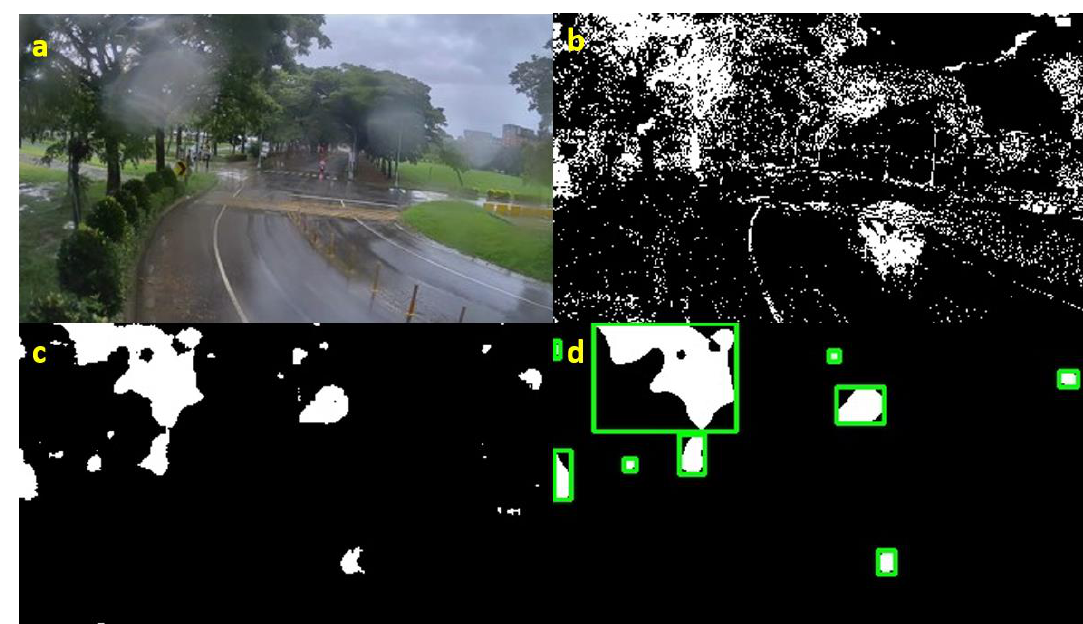
Figure 6. Processing flow for locating adherent raindrops. ( a ) Input image frame with adherent raindrops. ( b ) Difference result between the current frame and scene base frame on the value plane under the HSV color space. ( c ) Denoising result through medium blur. ( d ) Connected component visualization result.